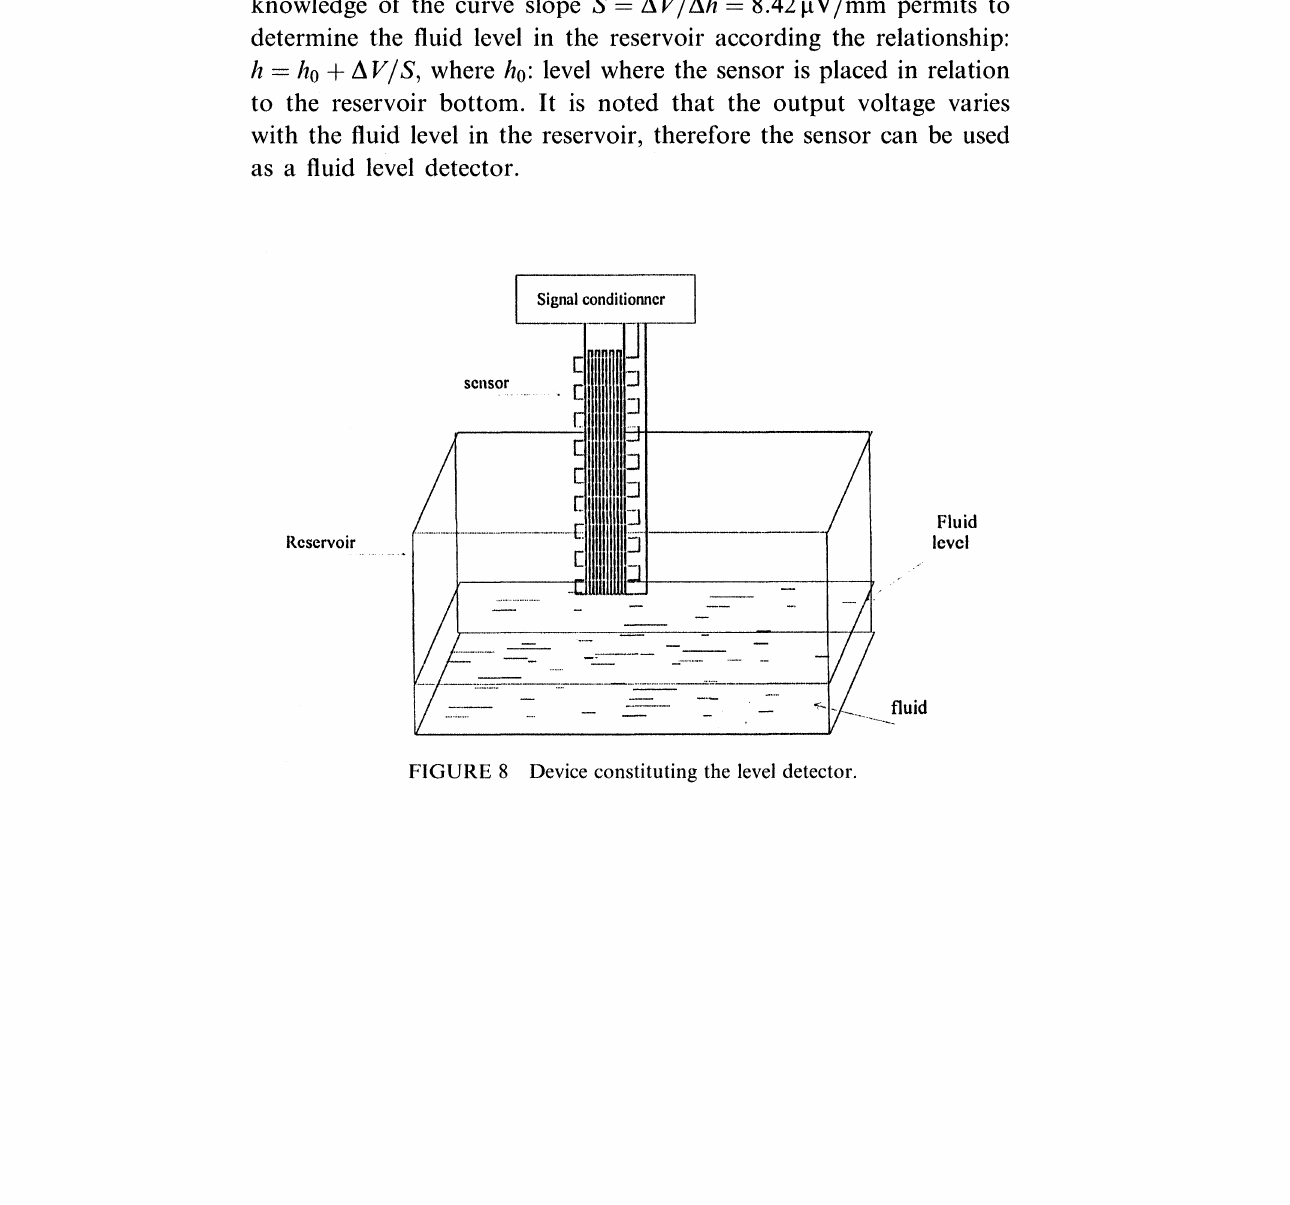
FIGURE 8 Device constituting the level